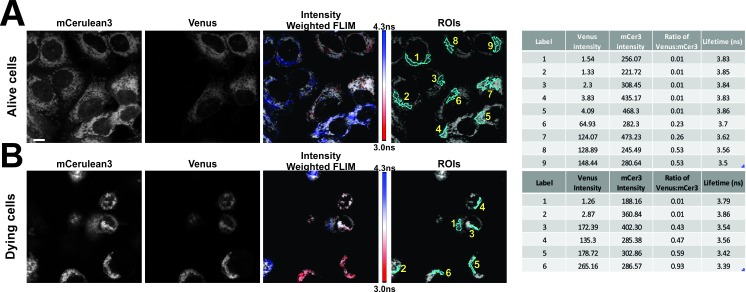
FLIM-FRET measurements for CBcl-XL binding to VBimEL-Bad in alive and dying MCF-7 cells.Representative micrographs selected showing mCer3 and Venus intensities, Intensity weighted FLIM and selected regions of interest (ROIs) for (A) alive and (B) dying cells. Lifetime determinations for mCer3 for the identified ROIs are presented in tabular form at the left. Ch1 – Venus intensity, Ch2 – mCer3 intensity, ratio of Venus to mCer3 – ratio, Lifetime for ROI – Tau. MCF-7 overexpressing mCer3-Bcl-XL were transiently transfected to express vBimEL-Bad and after treatment with DMSO for >16 hr images of live cells were acquired by imaging adherent flat cells, dying cells (spherical) were imaged from a higher focal plane one hour later due to the time needed to acquire the first set of data.